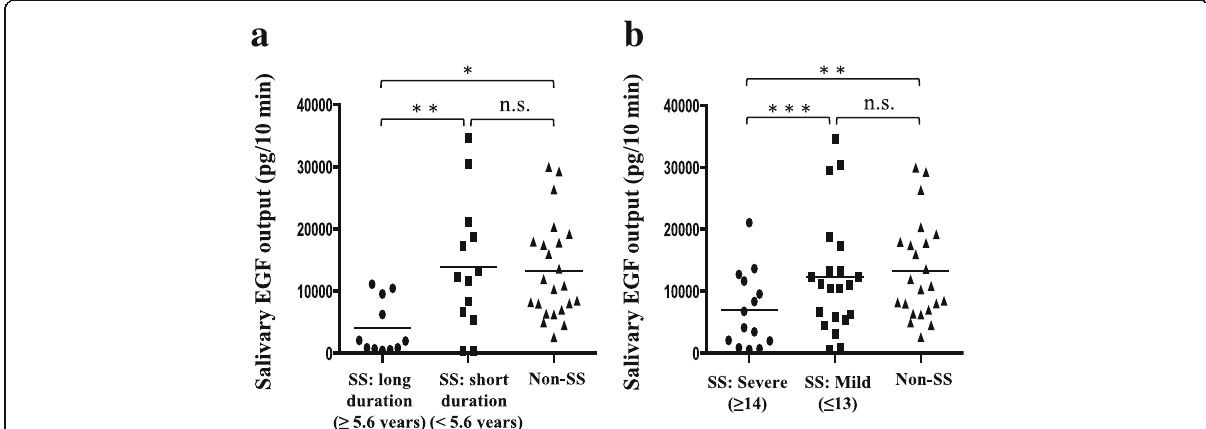
Fig. 1 Salivary epidermal growth factor (EGF) levels of the Sjögren ’ s syndrome (SS) and non-SS groups. a The SS group was divided into the long-duration group and short-duration groups depending on disease duration, and salivary EGF output levels were compared between these groups and the non-SS group. b The SS group was divided into the severe and mild groups according to the severity of intraoral manifestations determined using the Oral Health Impact Profile (OHIP)-14 score, and salivary EGF output levels were compared between these groups and the non-SS group. Statistical differences were assessed using the Mann − Whitney U test. * p < 0.001, ** p < 0.01, *** p < 0.05; n.s., not significant